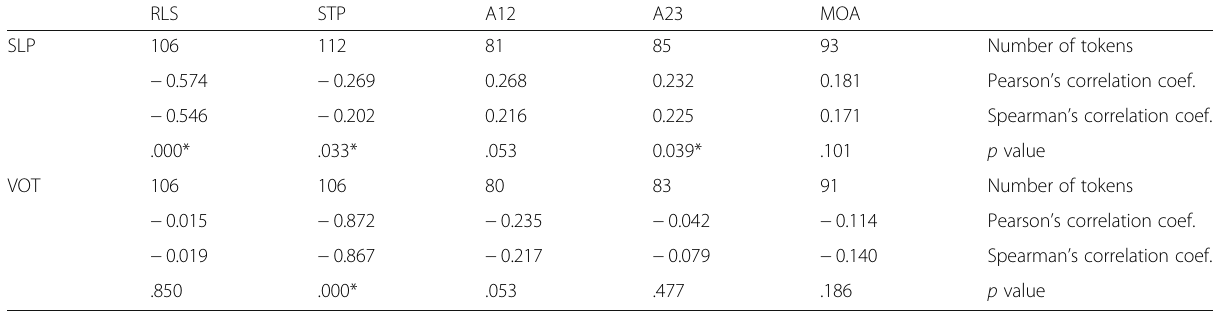
Table 9 Results from the correlation analysis: number of tokens; Pearson ’ s correlation coefficient; Spearman ’ s correlation coefficient, p value of the Spearman rank-based correlation test